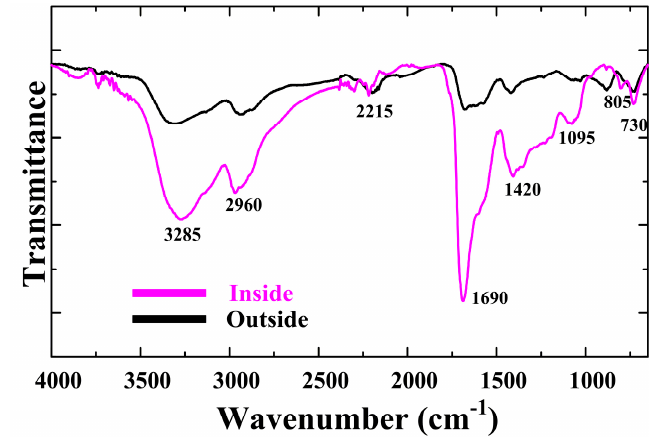
Figure 5. Changes in Fourier transform infrared spectroscopy (FTIR) spectra of pPPy nanofibers and nanoparticles thin film prepared using the proposed APPJs after a deposition of 60 min on